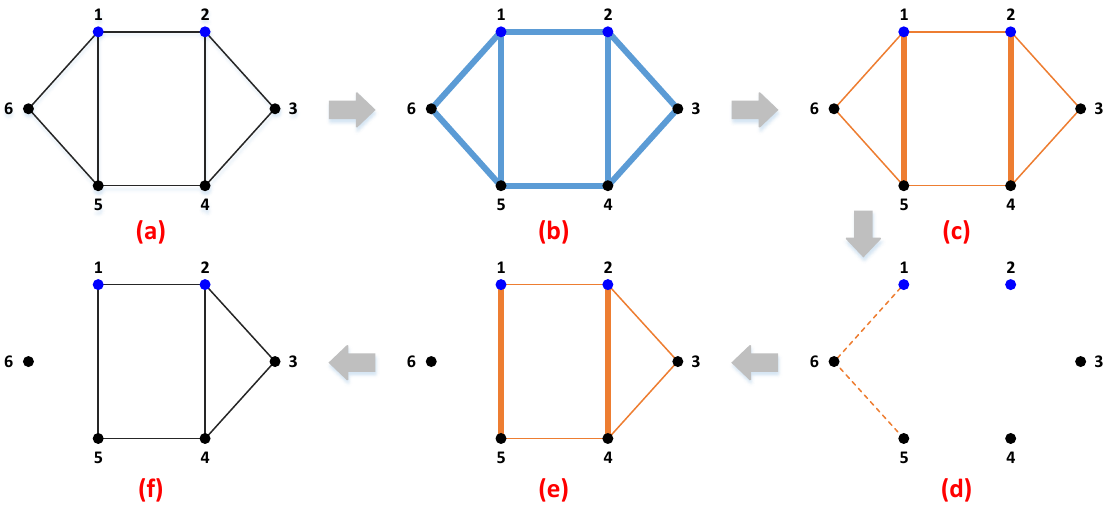
Figure 3. Demonstration of protection strategies in power system fortification: ( a ) original power system; ( b ) candidate protection branch set; ( c ) enhanced power system shown to the adversary; ( d ) deliberate attack plan; ( e ) expected power system by the terrorist after attack; ( f ) actual power system after